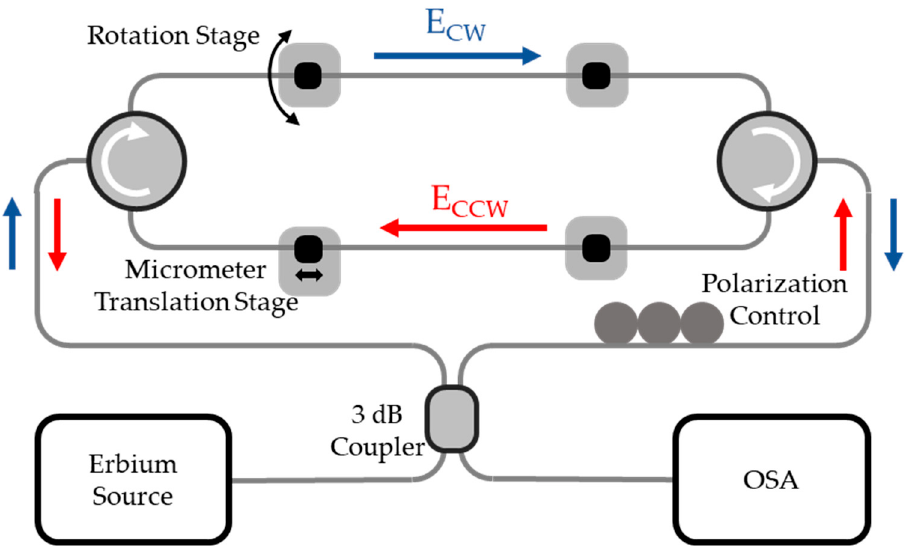
Figure 1. Optical system of FLM with optical circulators. The electric field of the system’s arms can be described